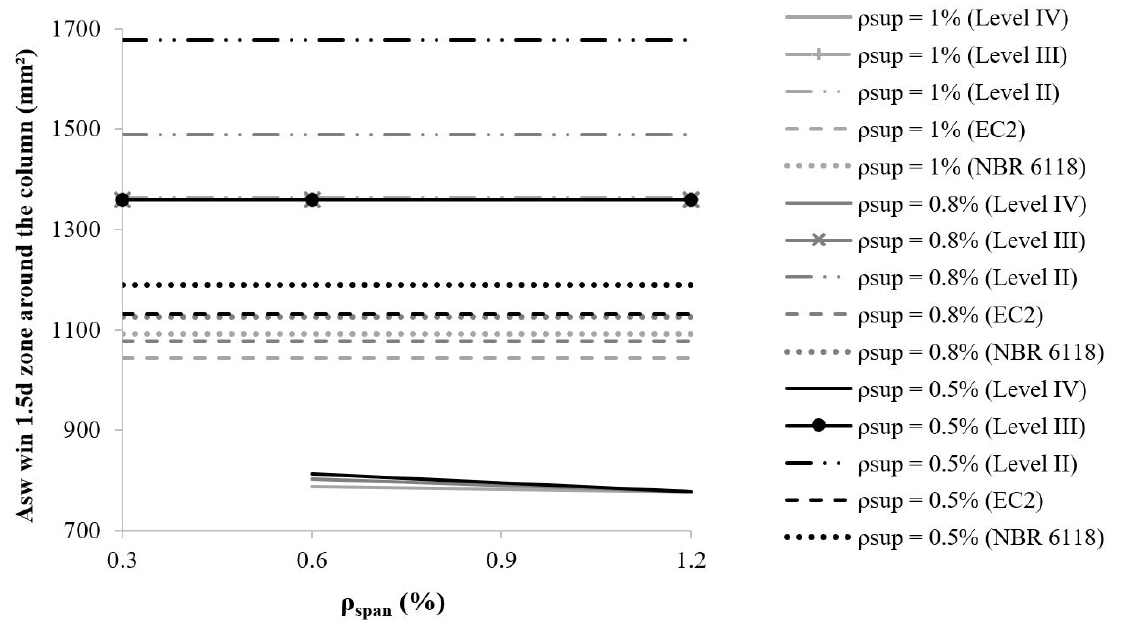
Figure 17. Shear reinforcement in 1.5d from the column required by MC2010, EC2 and